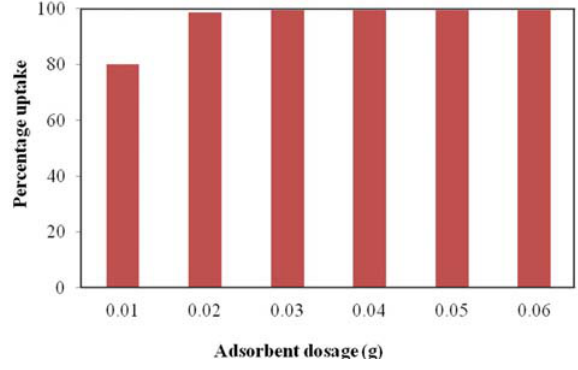
Figure 8. Effect of adsorption dosage on adsorption of MB by NTA-BP (Condition: 0.01, 0.02, 0.03, 0.04, 0.05 and 0.06 g of ad- sorbent in 20 mL of 100 mg/L dye solution at 150 rpm for 4 hours).